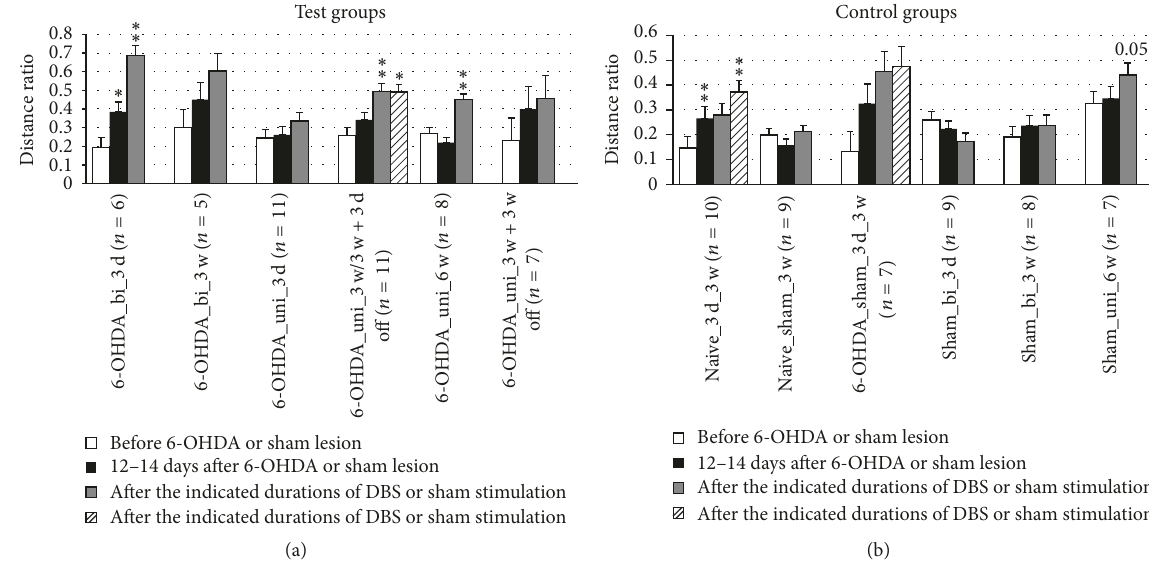
Figure 12: Short-term and long-term effects of DBS with uni- and bipolar electrodes on the anxiety-like behavior (b) of hemiparkinsonian rats as measured by the ratio: migration distance in the center/total migration in the open field. (a) and (b) refer to test groups and controls, respectively. Different column patterns indicate different times of behavioral testing; white: before 6-OHDA or sham lesion; black: 12–14 days after6-OHDAorshamlesion;grayandhatched:afterthedurationsofDBSorshamstimulationindicatedinthegrouplabels.Forexperimental details see Table 1. Significance levels are indicated with asterisks as follows: ∗∗ 𝑝 ≤ 0.01 , ∗ 𝑝 ≤ 0.05 , b (borderline): 0.05 < 𝑝 ≤ 0.08 according to one-way ANOVA. Asterisks above black columns refer to white columns; all others refer to black columns. Table 2: Summary of test results. The improvement and worsening of lesion-induced parkinsonian symptoms by DBS are marked by (+) and ( − ), respectively. Borderline changes (0.05 < 𝑝 ≤ 0.08) are marked by (b); parameters with no detectable DBS effects are marked (0); n.d. stands for “not determined.” The results marked with an asterisk could not be interpreted in terms of the therapeutic DBS